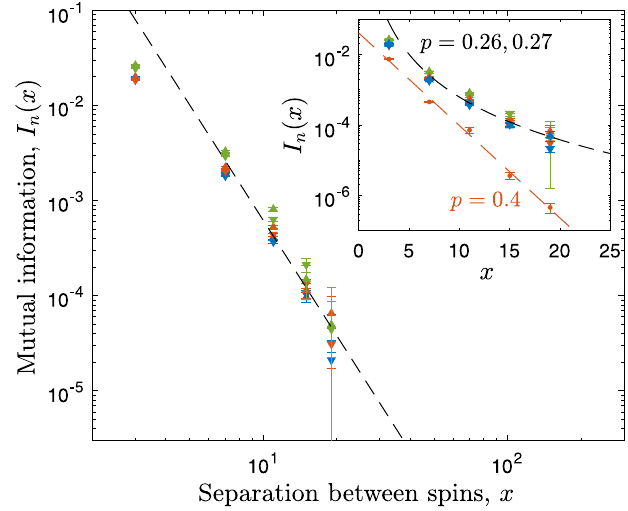
FIG. 15. Dependence of the mutual information I between two n x Þ for spins on their separation x . The main figure shows I n ð values of p that are close to the critical value p . The plotted data c are taken from simulations of the random unitary dynamics, for 0 . 267 (cid:4) 0 . 027 . Blue, red, and green symbols cor- which p c ¼ respond, respectively, to n ¼ 1 , n ¼ 2 , and n → ∞ , while upward- and downward-facing triangles correspond, respectively, to p ¼ 0 . 26 and 0.27. The dashed line shows the relation I ∝ 1 =x 4 , as in the classical problem. The inset shows these same data on a semilogarithmic scale, along with results for I 1 ð x Þ at p ¼ 0 . 4 , which is away from the critical point. These latter results are well fit by an exponential dependence (red dashed